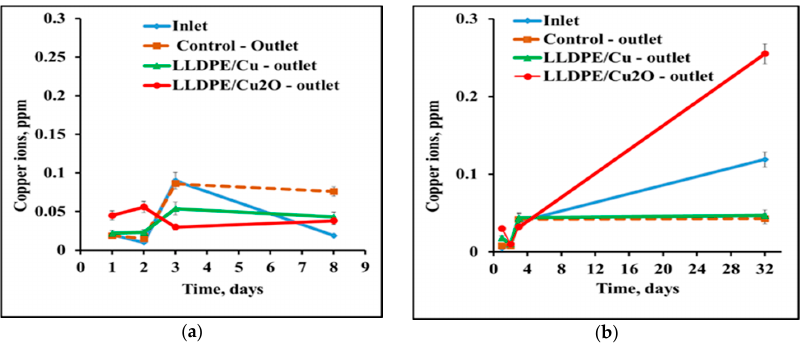
Figure 5 . Leaching of copper ions from composites of LLDPE and NPs of copper and copper oxide into bacterial suspensions of ( a ) S. aureus and ( b ) E. coli in saline in a continuous experiment. Copper concentration was measured at the inlet to the system and at the outlets from the columns with composites LLDPE/CuNPs and LLDPE/Cu 2 ONPs, and from a control column not containing composites.